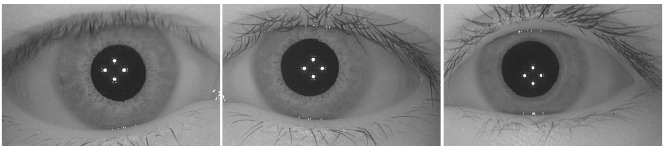
Figure 2. Sample images from the (Chinese Academy of Sciences’ Shenzhen Institutes of Advanced Technology) CAS-SIAT-Iris dataset.